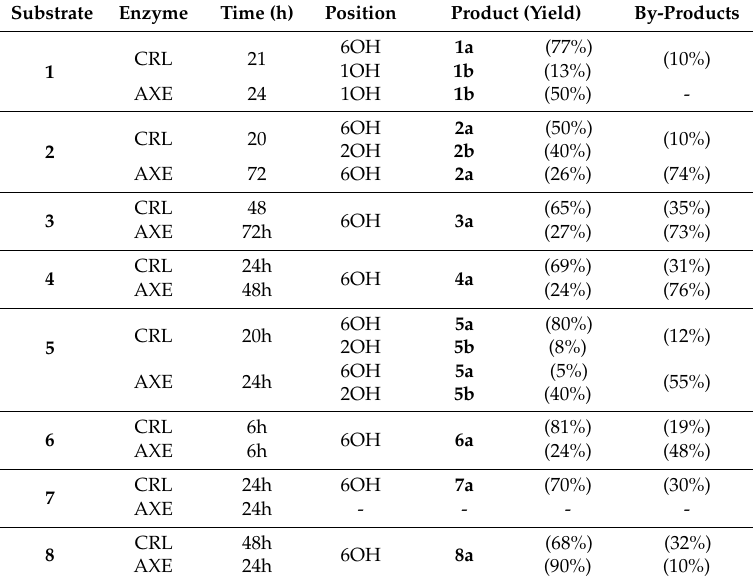
Table 2. Regioselective enzymatic hydrolysis of